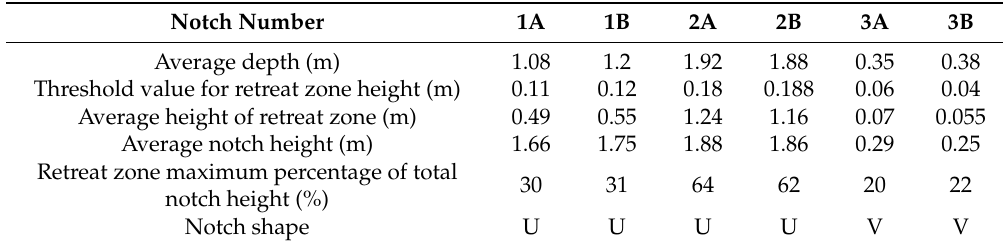
Table 5. Summary of notch profiles. Parameters acquired on the basis of point cloud (A) and DSM (B). Notch